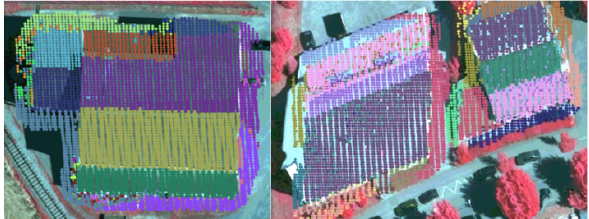
Fig. 4. Examples of roof plane detection, each plane shown in another